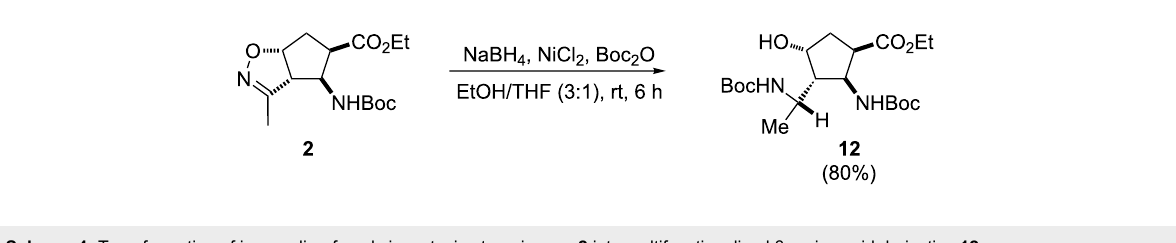
Scheme 4: Transformation of isoxazoline-fused cispentacin stereoisomer 2 into multifunctionalized β -amino acid derivative 12 .